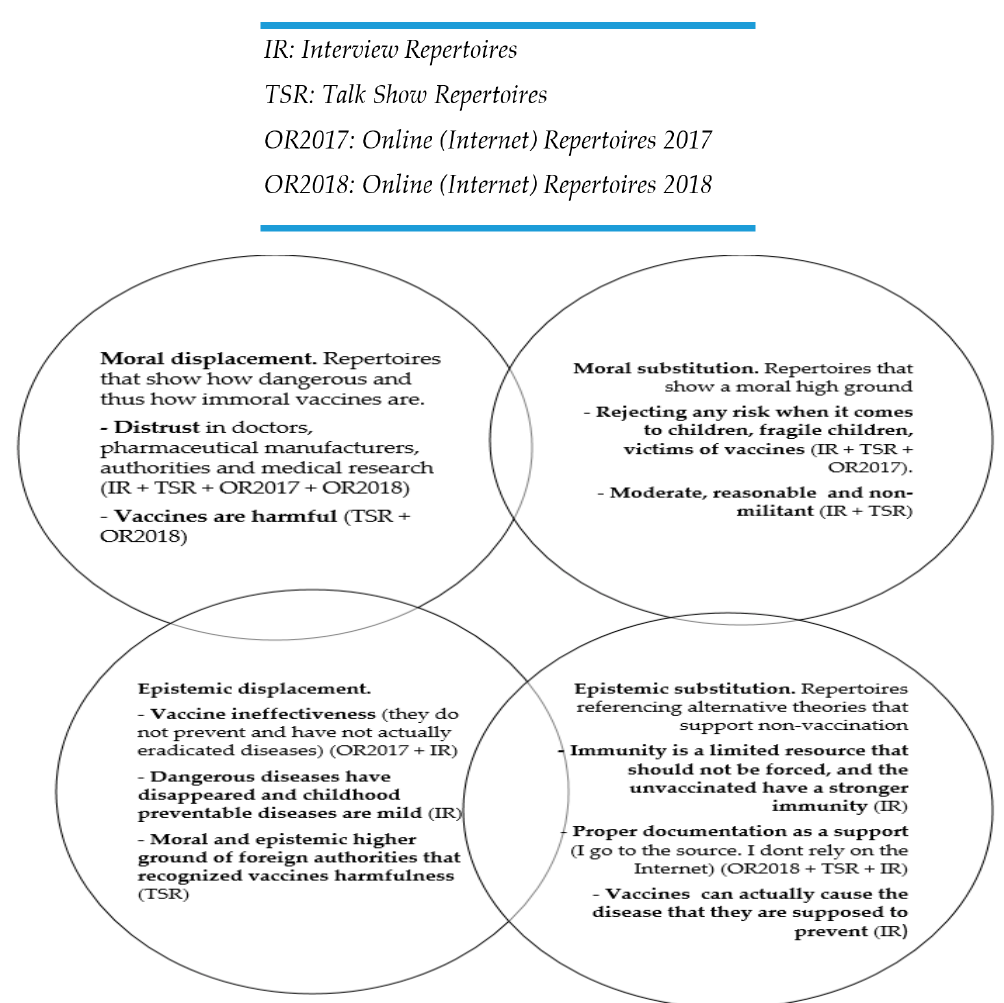
Figure 1. Identified antivaccine repertoires grouped according to discursive legitimizing- delegitimizing functions.